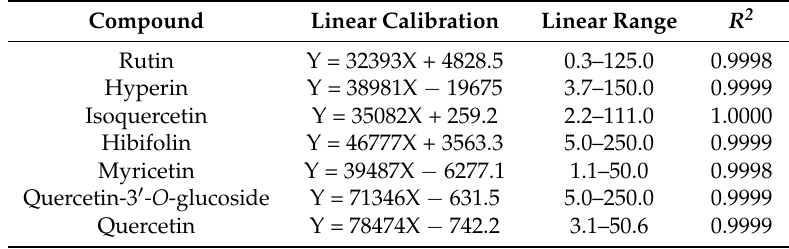
Table 4. Linear calibration curves, linear ranges and correlation coefficients for the seven flavonoids. Compound Linear Calibration Linear